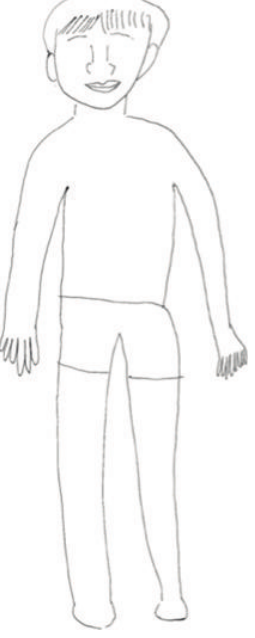
Figure 1: A human figure drawing by